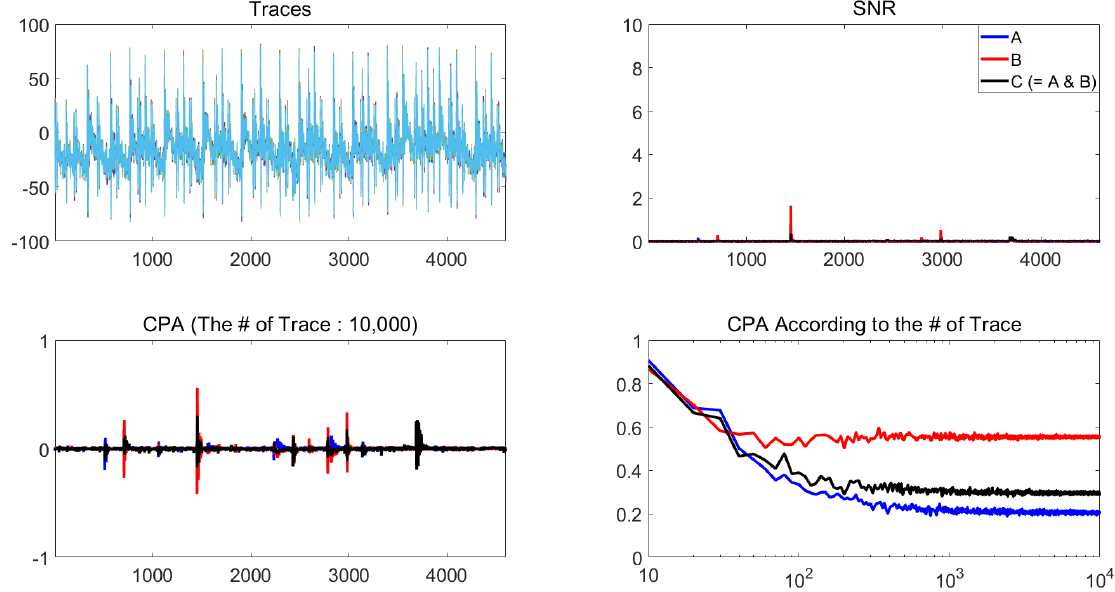
Figure 2. Evaluation results of our